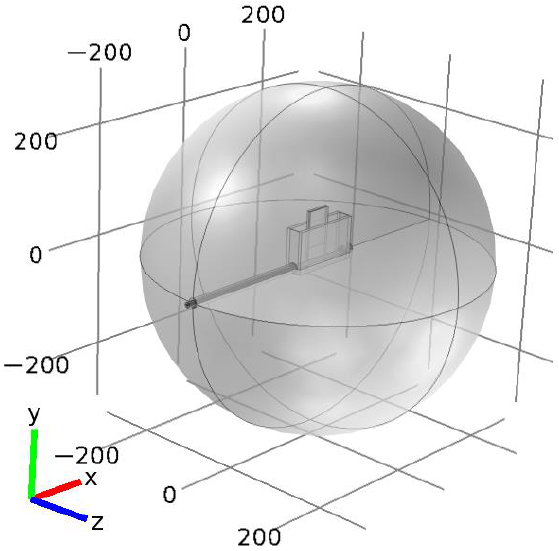
Figure 4. General view of the MPSS model in Cartesian coordinates with the radiation sphere.